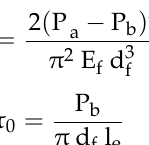
Figure 5. (a) Specimen and (b) test apparatus for single fiber pullout test.